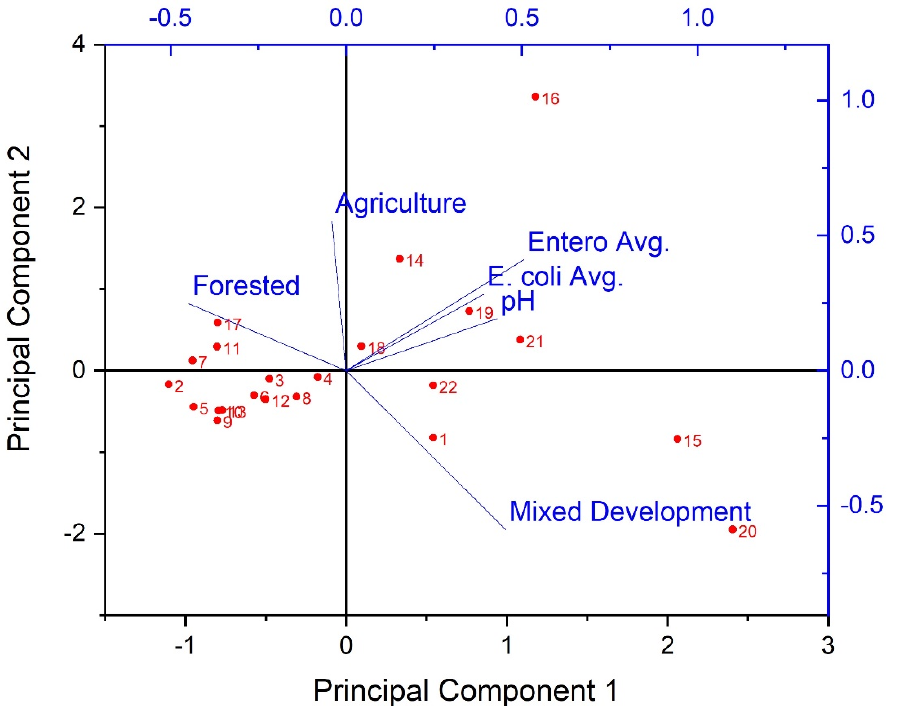
Figure 5. Results of Principal Components Analysis (biplot) for extracted principal components of stream fecal indicator bacteria and pH data, explaining 85% of the dataset cumulative variance during the study period (3 March − 3 November 2020) and land use/land cover characteristics in West Run Watershed, WV, USA. Red labels denote study site #s; axis scale has been adjusted to maximize visibility.